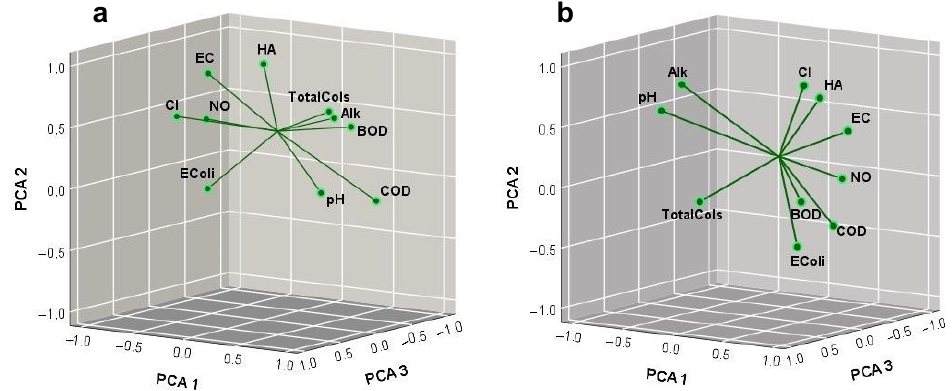
Figure 2. Spatial distribution of components. a HEC and b Households.